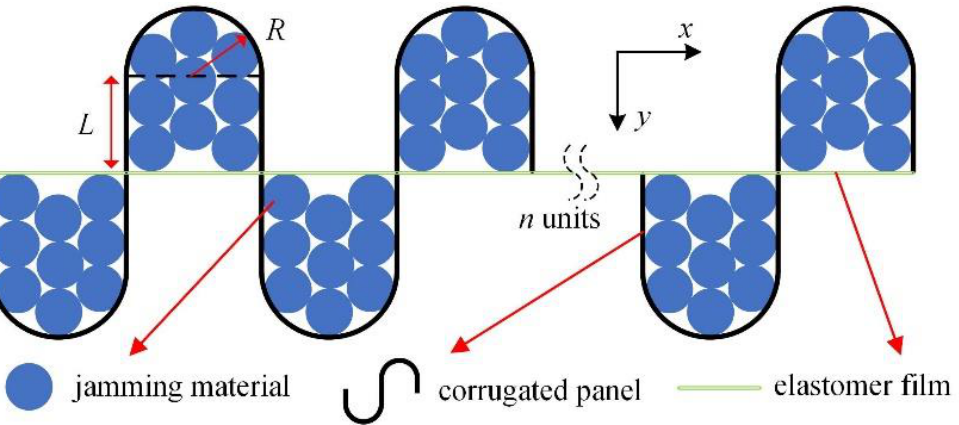
Figure 7. Concept of a reinforced corrugated panel.